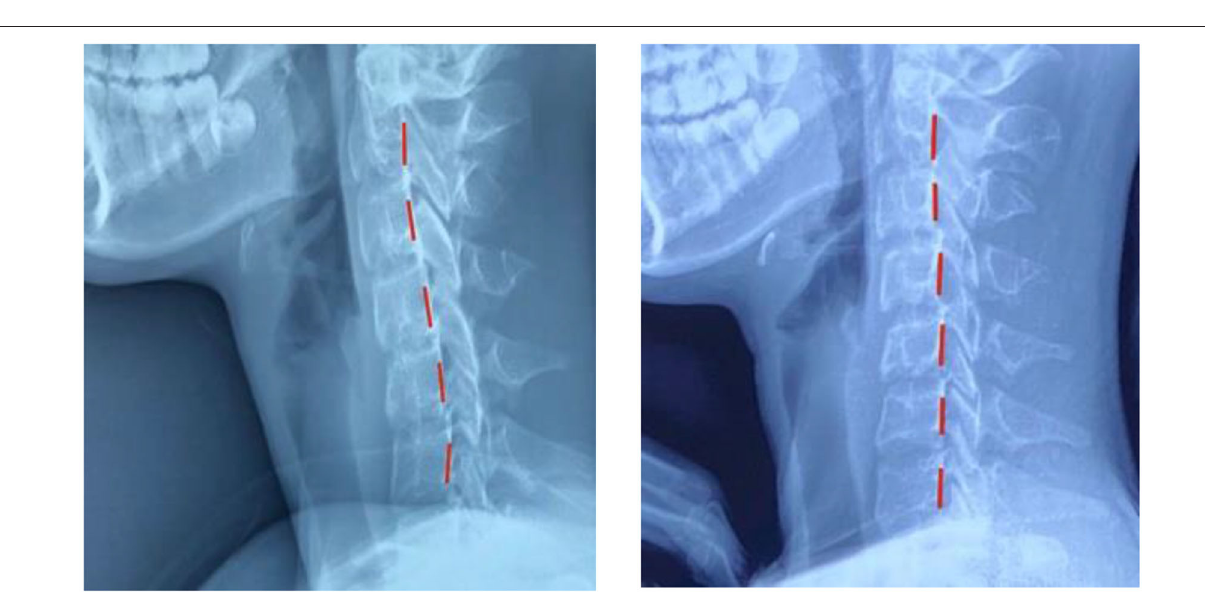
rehabilitation program that involves less in-clinic treatments and more in-home exercises and procedures is more favorable for successful